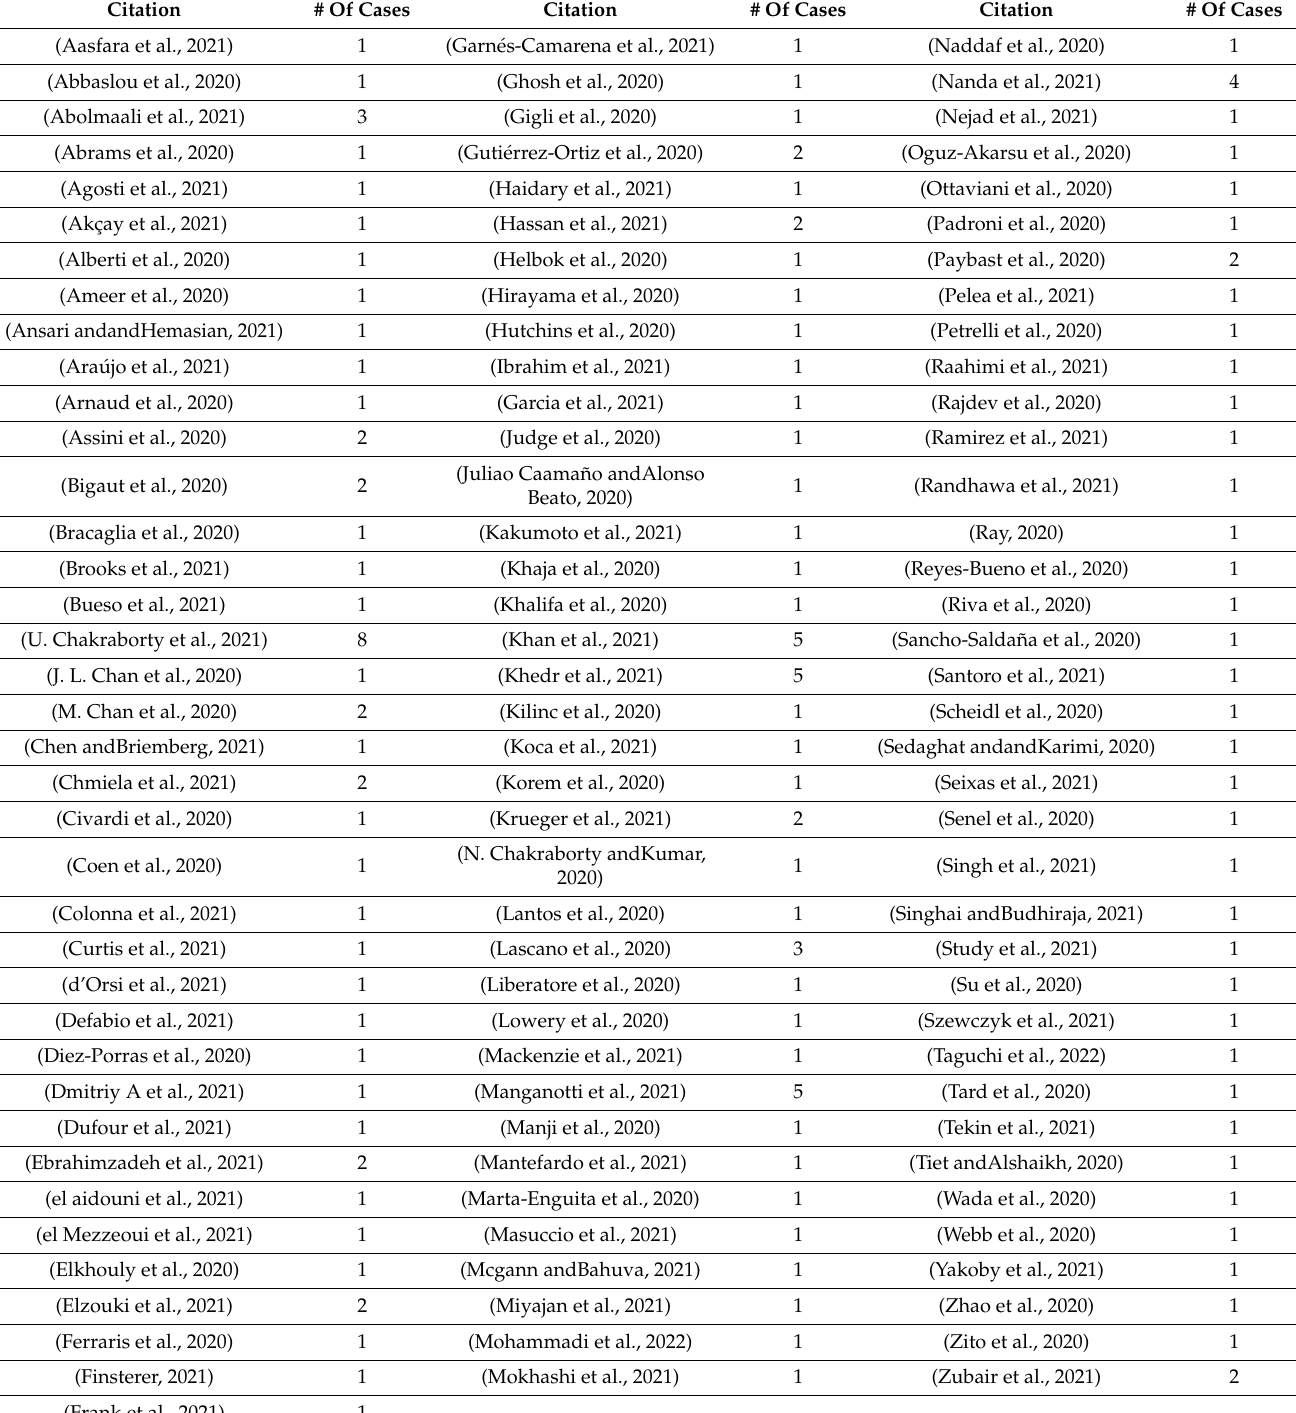
Table A3. Articles included in the meta-analysis (147 cases in 112